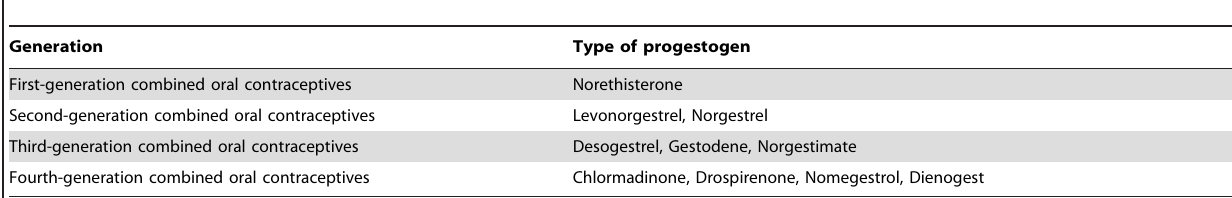
Table 1. Classification of combined oral contraceptives according to the type of